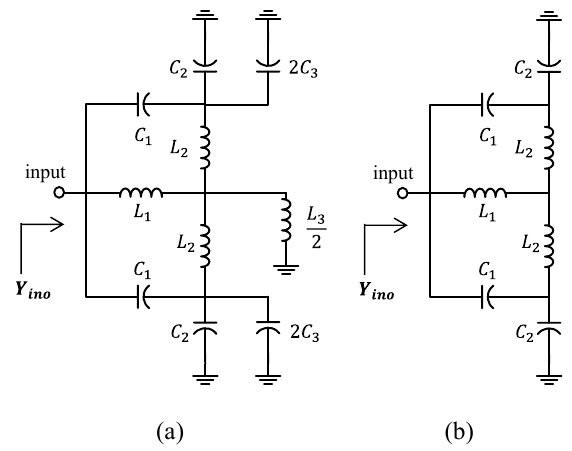
Figure 3: Equivalent LC circuit of (a) even mode and (b) odd mode of the proposed